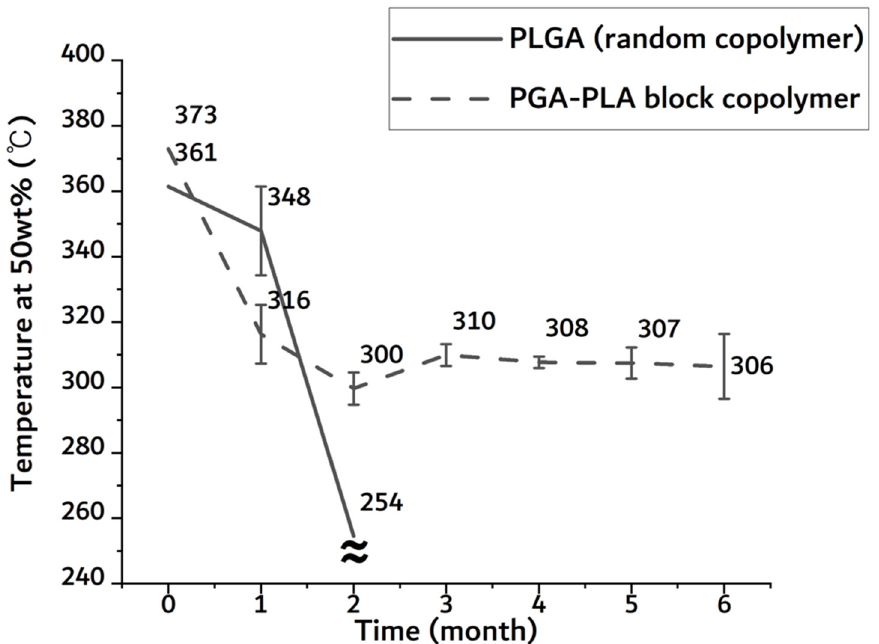
Figure A1. Temperature of half-mass trace of extracted sample 0 to 6 months after insertion from TGA.